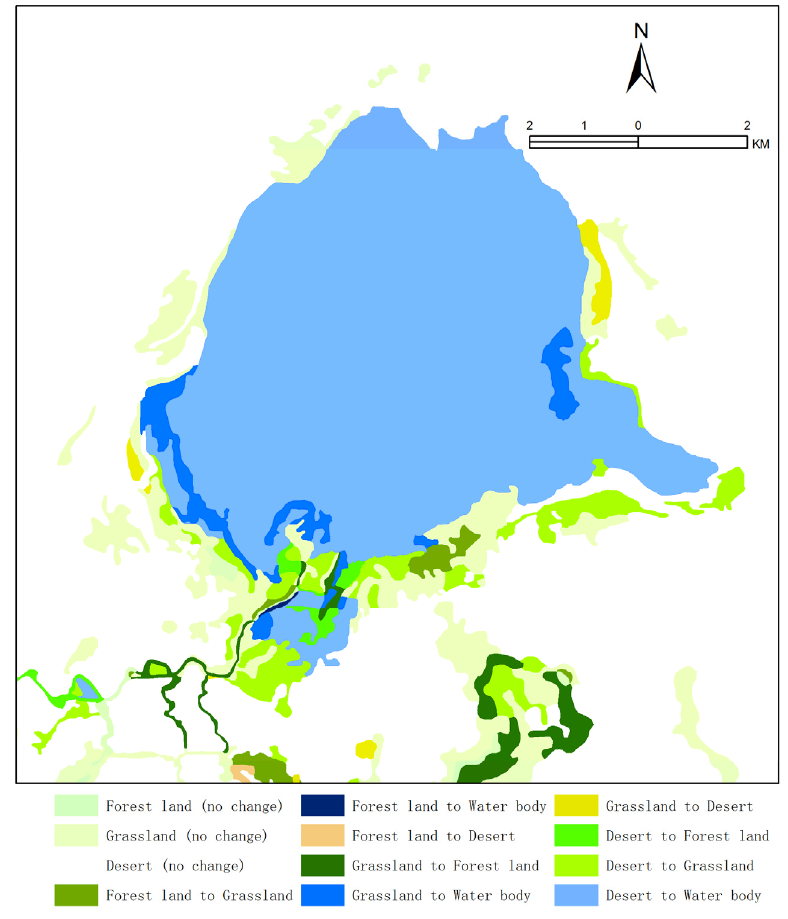
Figure 3. Land use changes around Sogo Nuur between 2000 and